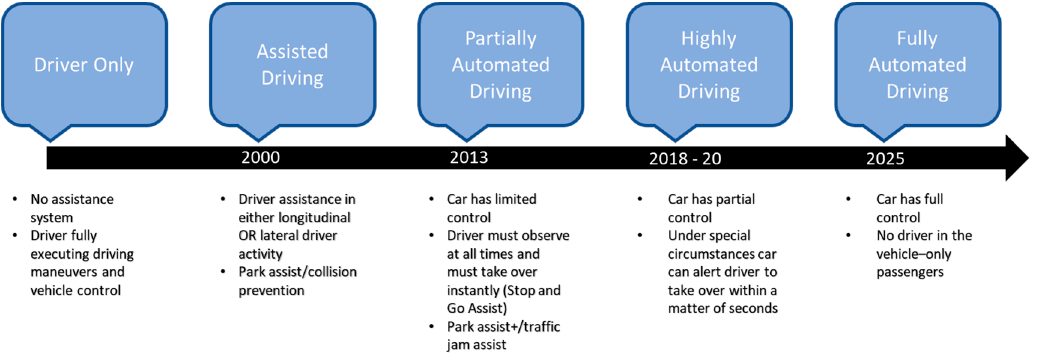
Figure 1. Timeline for complete autonomy [21] (rendition by authors).